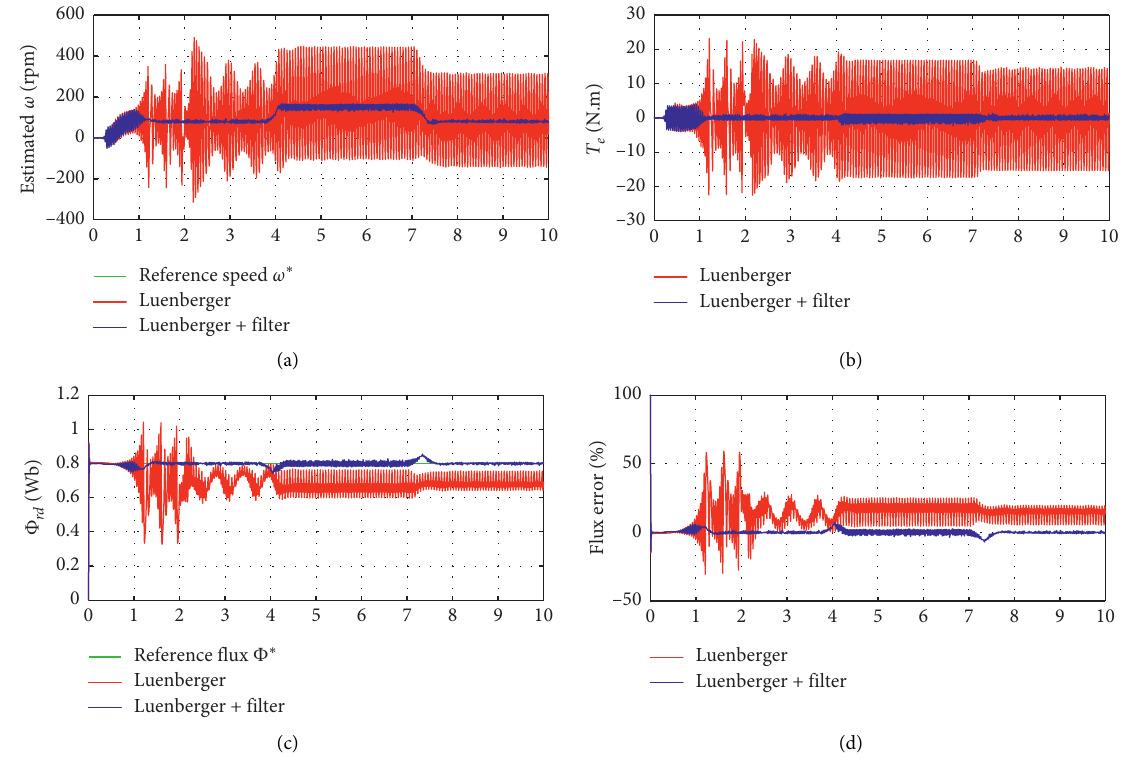
Figure 14: (a) Estimated speed. (b) Electromagnetic torque. (c) d -axis rotor flux. (d) Flux error.